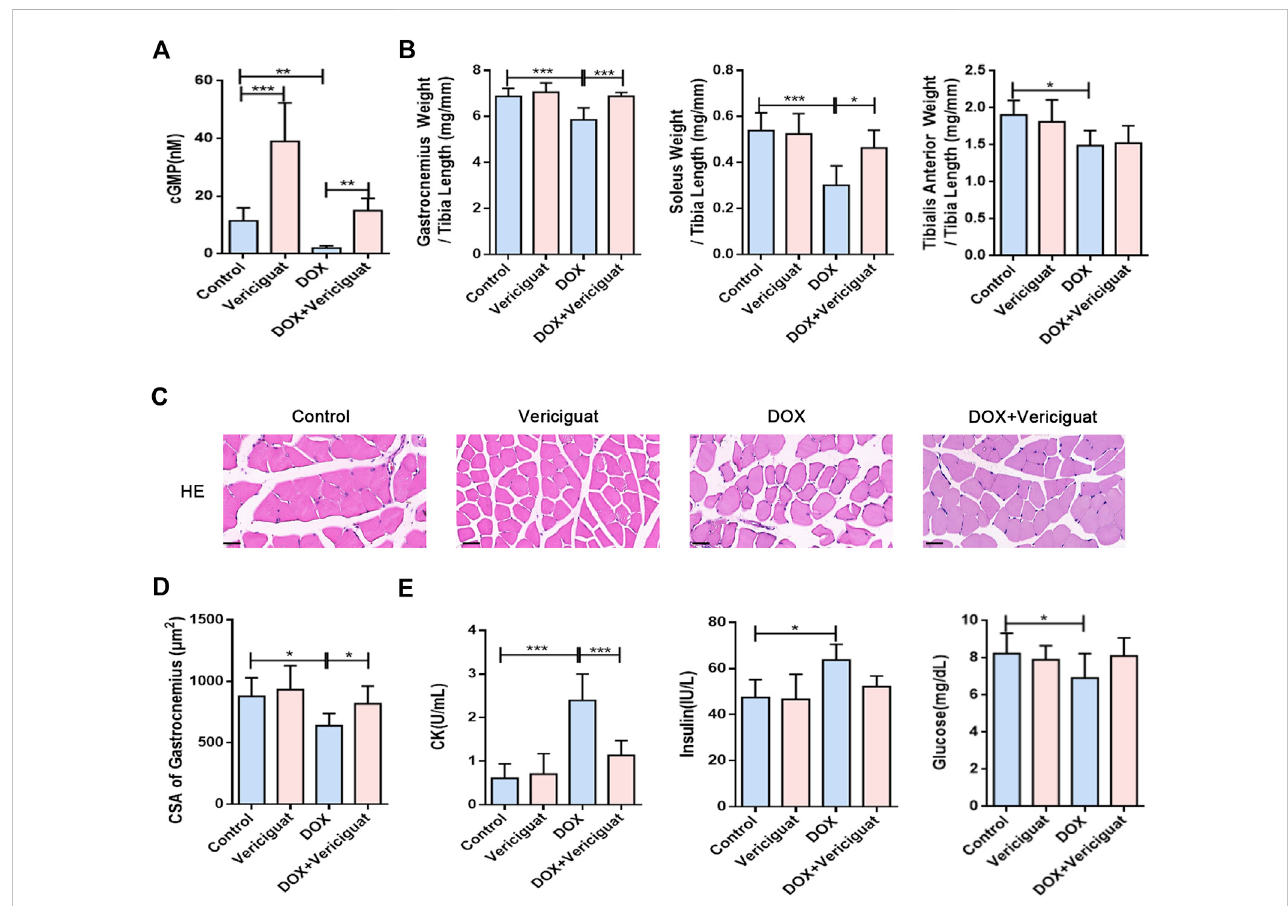
FIGURE 2 Vericiguat alleviated skeletal muscle atrophy and muscle injury. (A) Detection of cGMP content in mice by Elisa. (B) The ratios of the gastrocnemius muscle, soleus muscle, and tibialis anterior muscle weight to tibia length (mg/mm). (C) Representative HE staining of gastrocnemius muscle CSA (Scale bar: 50 μ m). (D) CSA of gastrocnemius muscle fi bres in different treatment ( μ m 2 ). (E) Serum levels of CK, insulin and glucose. n = 5 – 7; *p < 0.05, **p < 0.01, ***p <